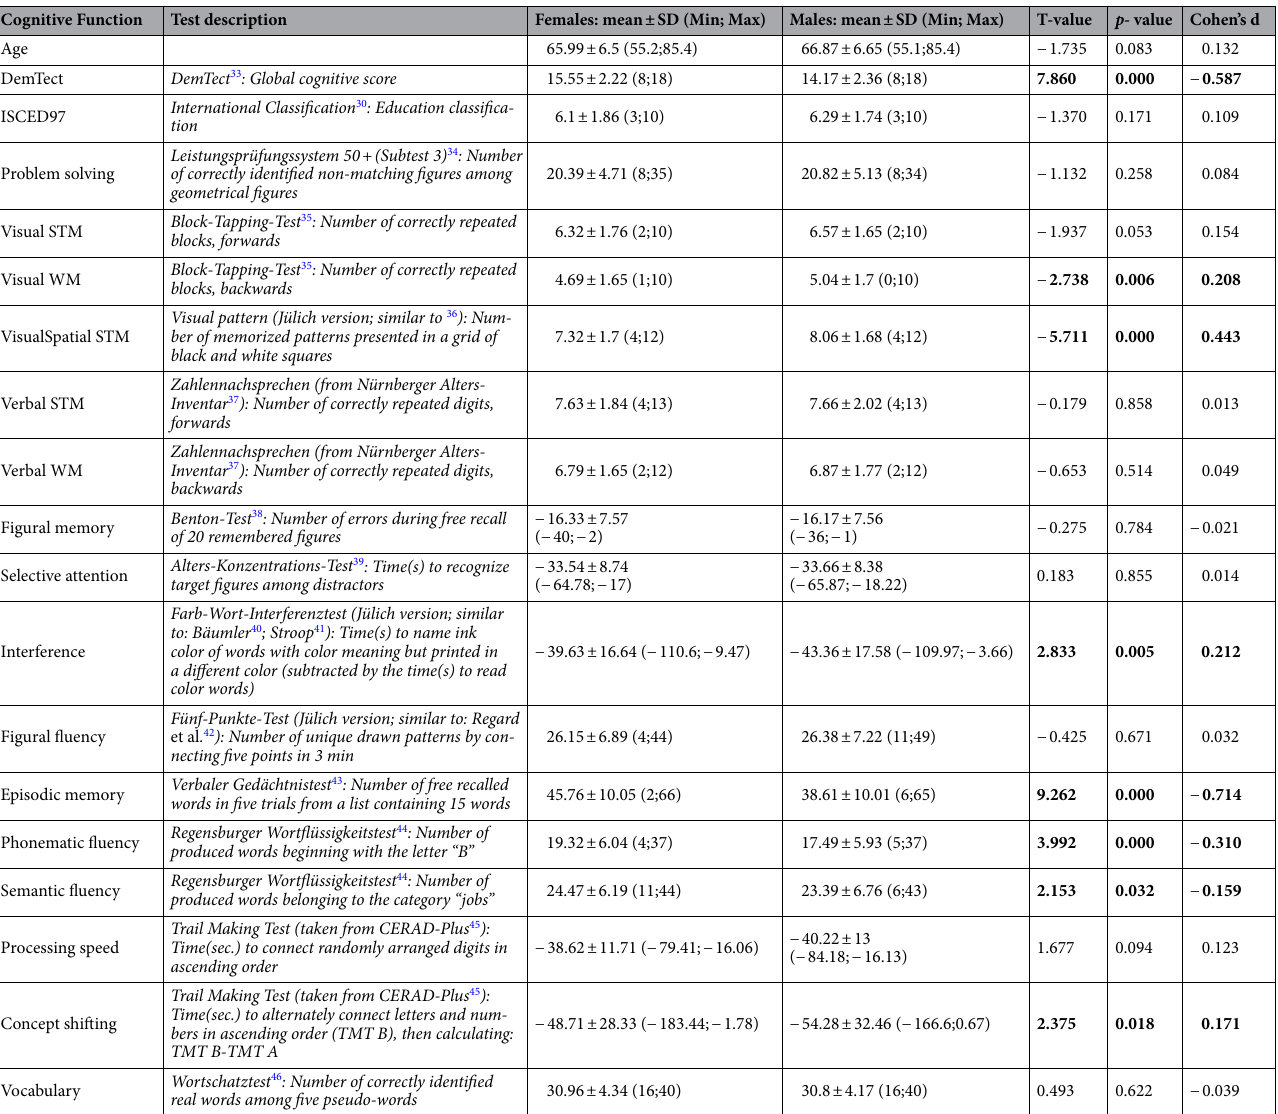
Table 1. Descriptives of neuropsychological variables including cognitive functions, tasks used, mean and standard deviation (SD) and Min; Max values, T value of group comparison with corresponding p value and effect size measured with Cohen ′ s d. Values written in bold indicate significant differences between groups ( p < .05). STM = short-term memory, WM = working